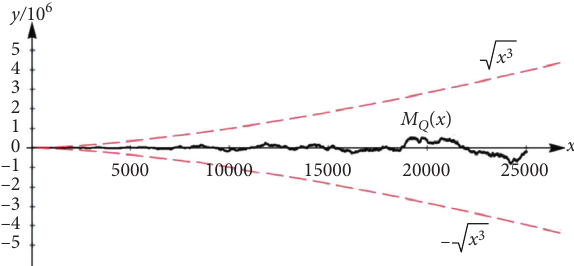
Figure 4: Graph of M ( n ) (black colored), for n from 1 to 25,000 Q between the bounds ± x ( 3/2 ) (red color dashed line).